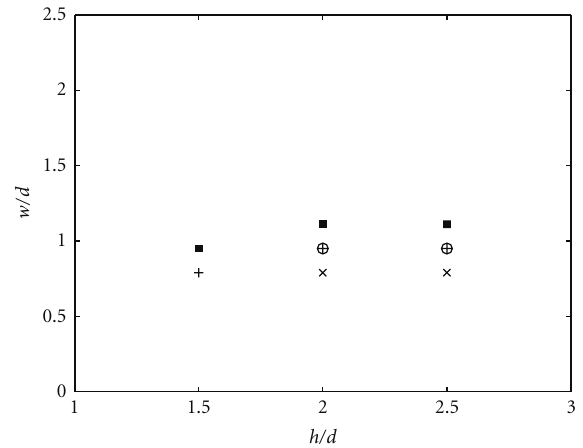
Figure 6: Canonical and live-bed results for the pile group with Γ = 3. I = 1 . 3 no fail (black squares); I = 1 . 3 fail (+); I = 1 no fail (circles); I = 1 fail (crossed).